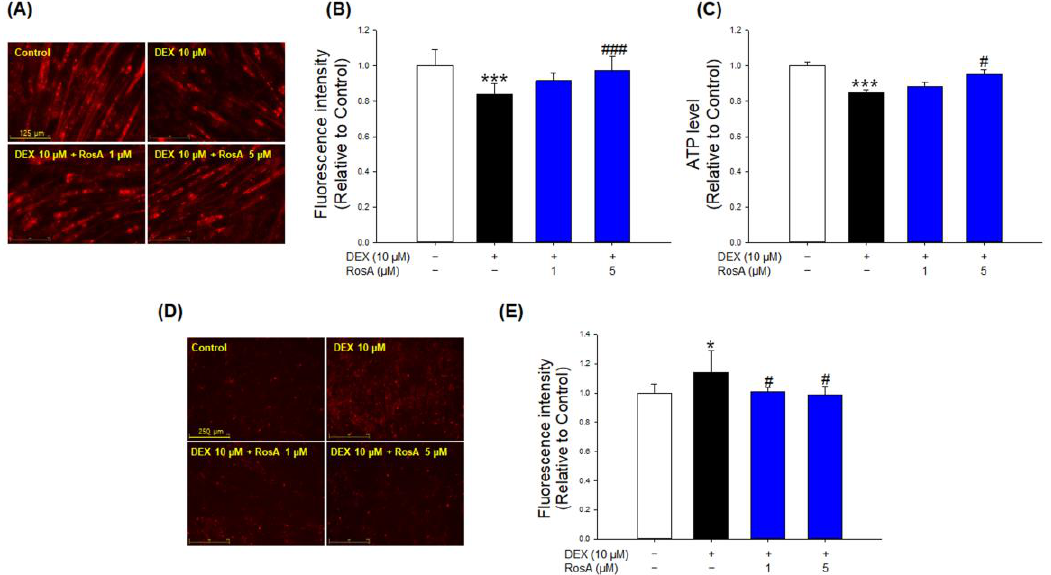
Figure 6. Effects of RosA on the mitochondrial content and ROS and ATP levels in DEX-treated C2C12 myotubes. ( A ) The mitochondrial contents were determined by MitoTracker Deep Red staining and observed by a fluorescence microscope (scale bar = 125 μm ). ( B ) The graph shows the quantification of the MitoTracker Deep Red stained area by the ImageJ software program (1.48 version). ( C ) ATP production in the C2C12 myotubes. ( D ) Fluorescence images from MitoSOX Red in C2C12 myotubes (scale bar = 250 μm ). ( E ) Quantification of the MitoSOX Red fluorescence-stained area. These results are presented as means ± SD of three independent experiments: * p < 0.05, *** p < 0.001 vs. control; # p < 0.05, ### p < 0.001 vs. DEX.